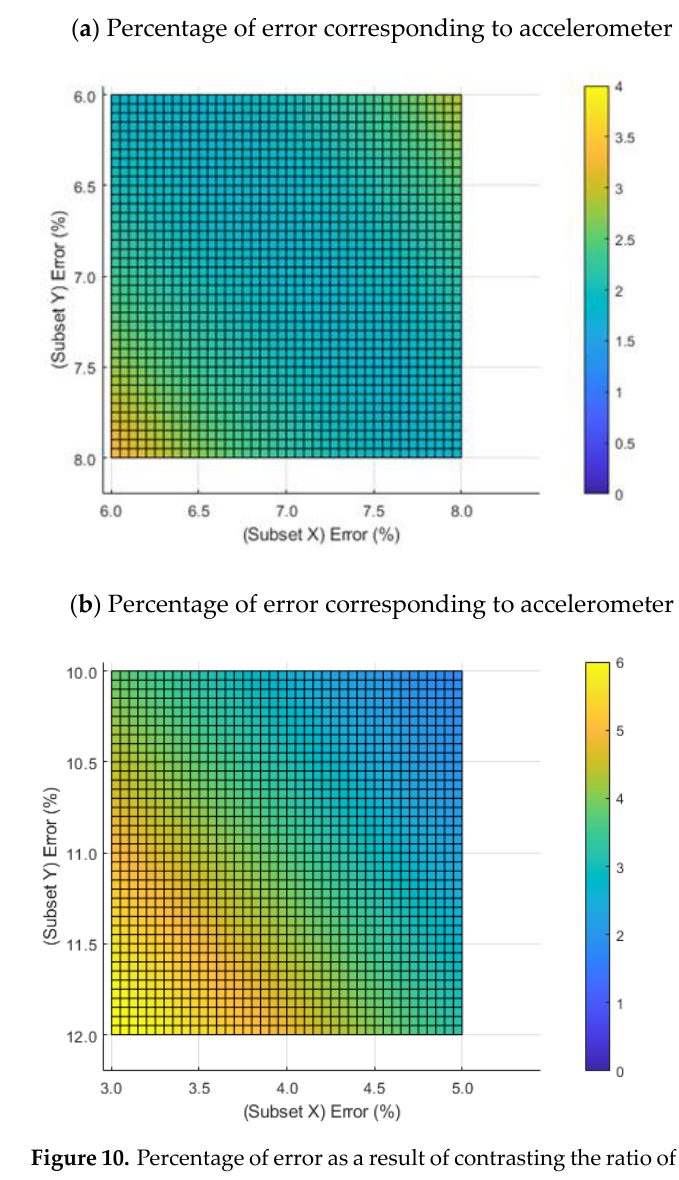
Figure 10. Percentage of error as a result of contrasting the ratio of the accelerometers with respect to the displacements calculated by the 3D‑DIC technique in a surface range of − 1 to +1 subsets around the accelerometer: ( a ) accelerometer 2; ( b ) accelerometer 3. The color bars represent the percentage of error.